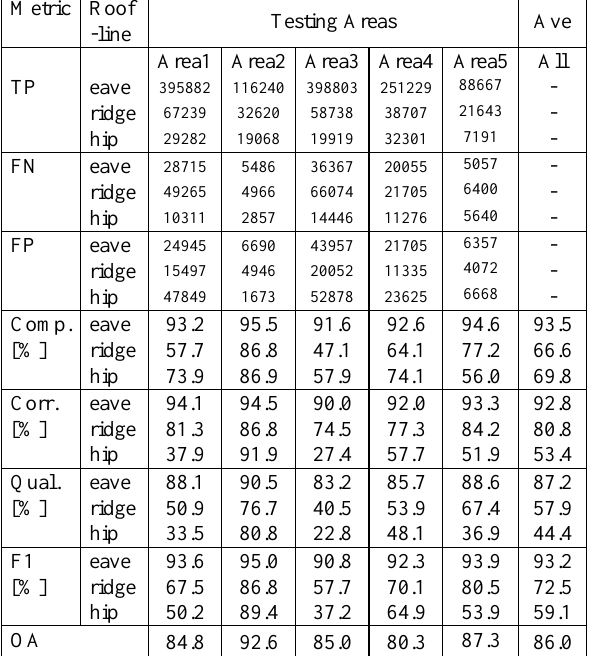
Table 3. The accuracy of the predicted rooflines